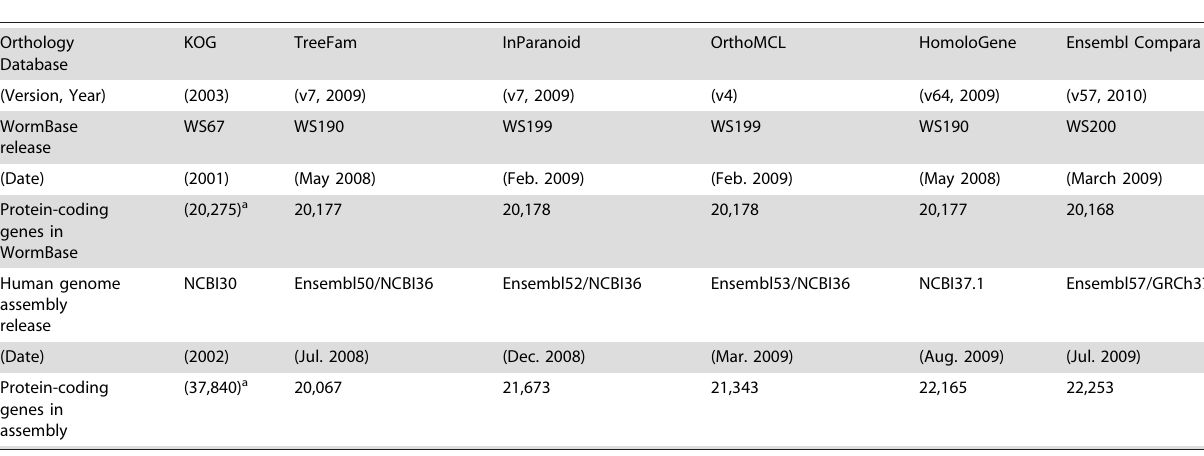
Table 1. C. elegans and human genome releases underlying orthology prediction programs.